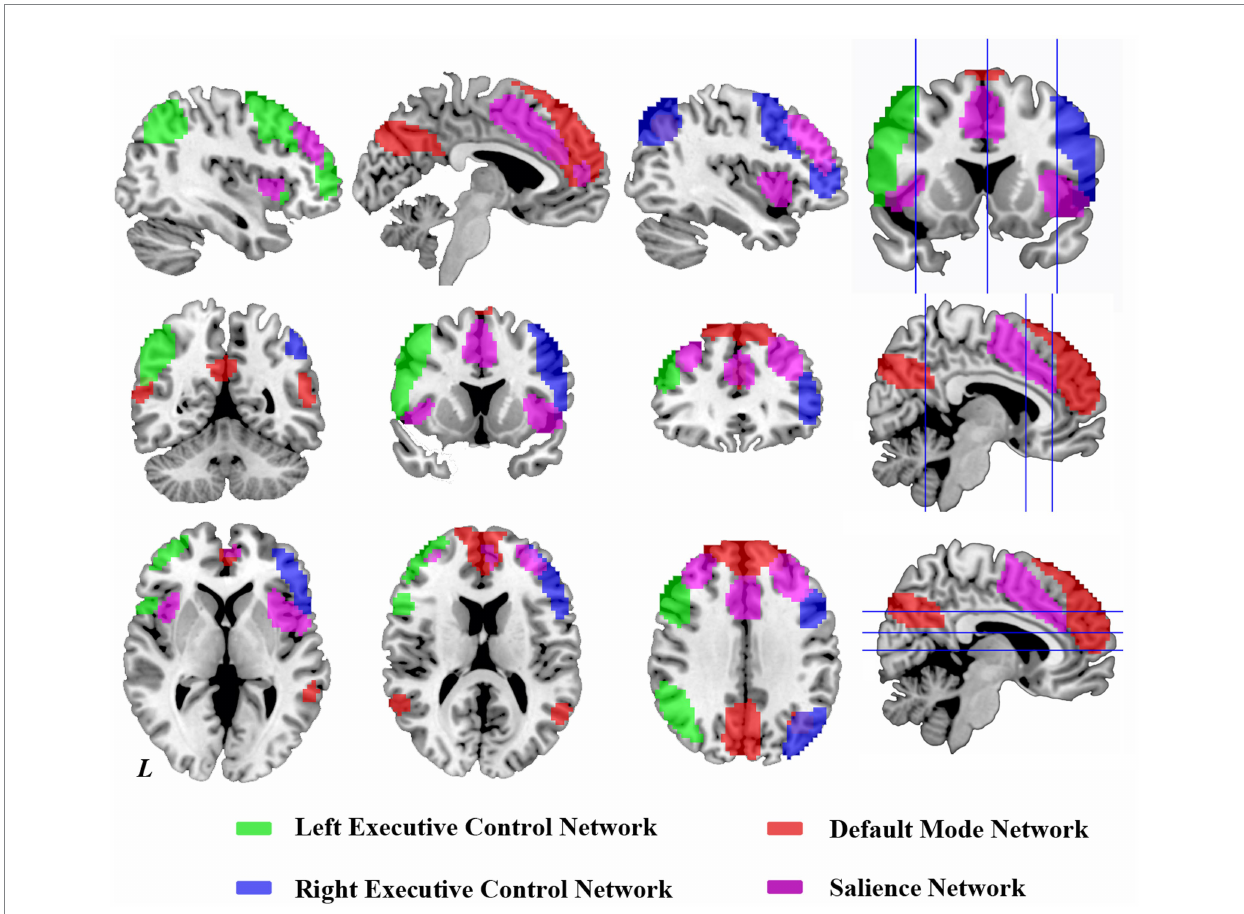
FIGURE 1 Brain networks revealed by the group-level independent component analysis.